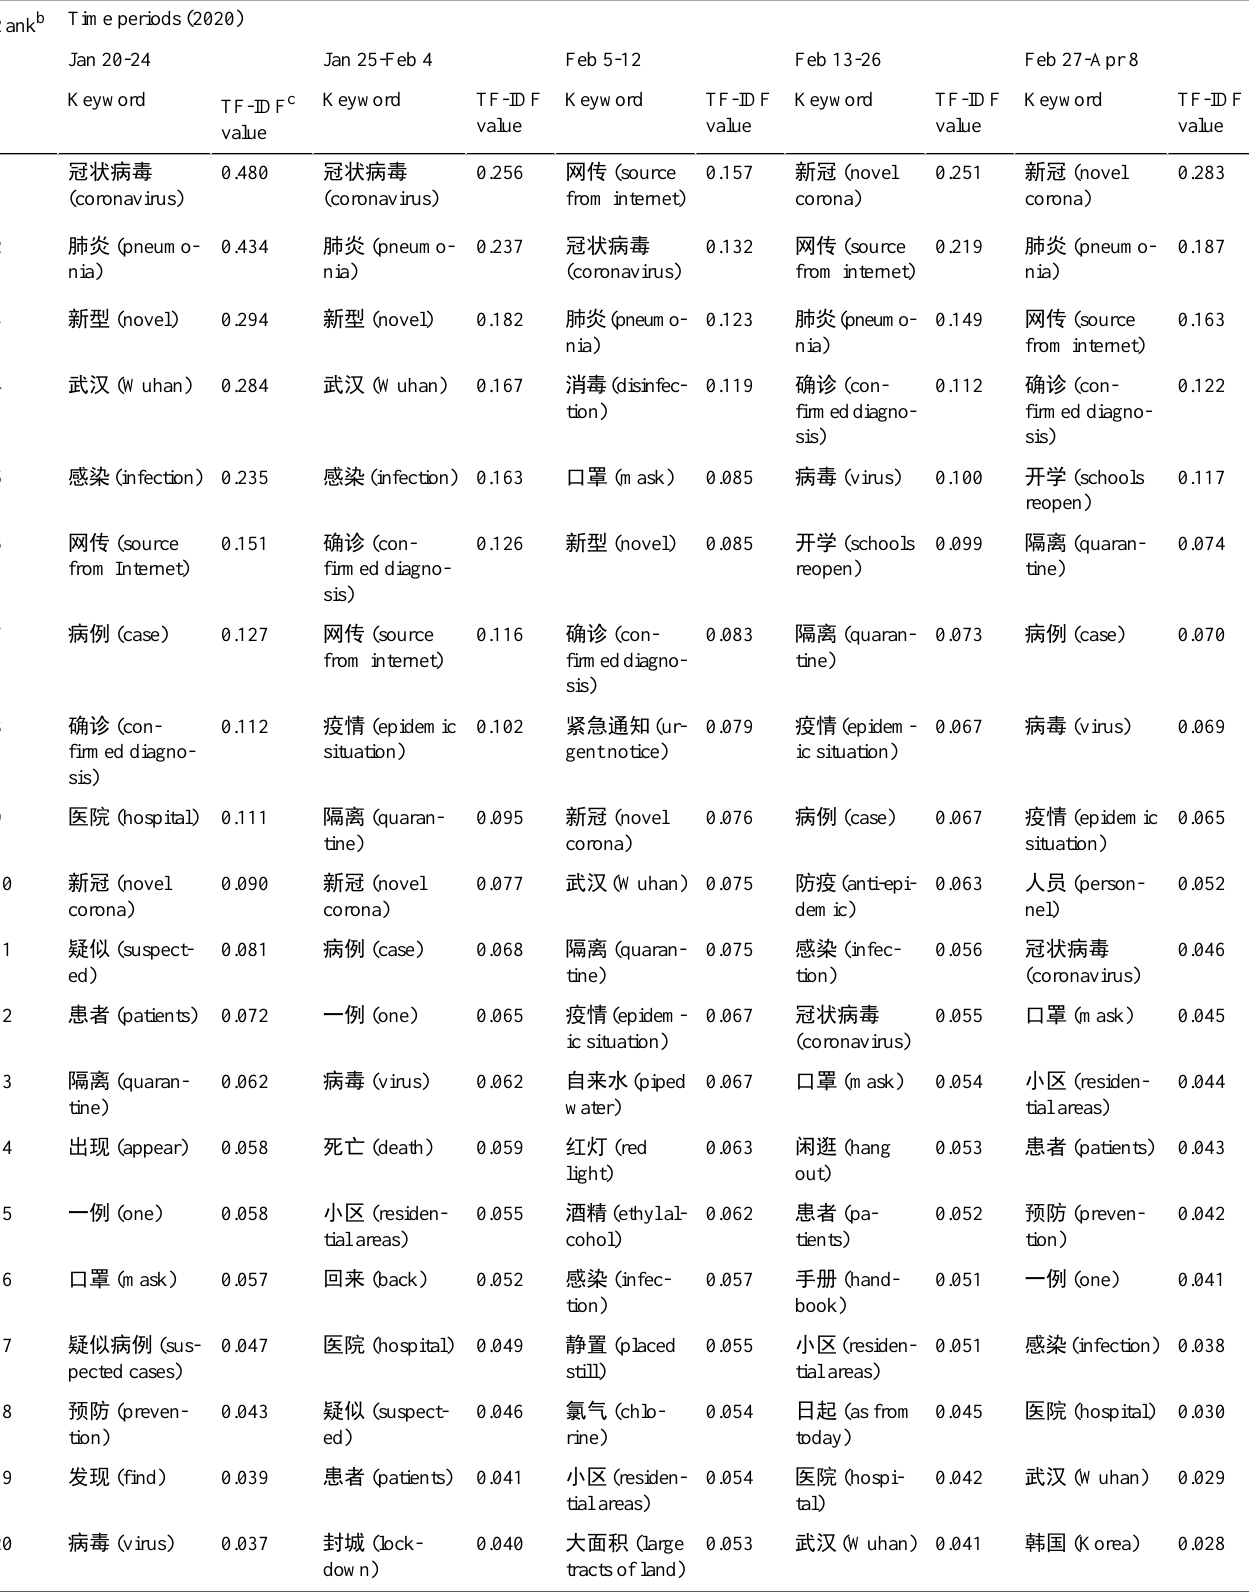
Table 4. The top 20 keywords in rumors across five periods during the outbreak of COVID-19 in China. a